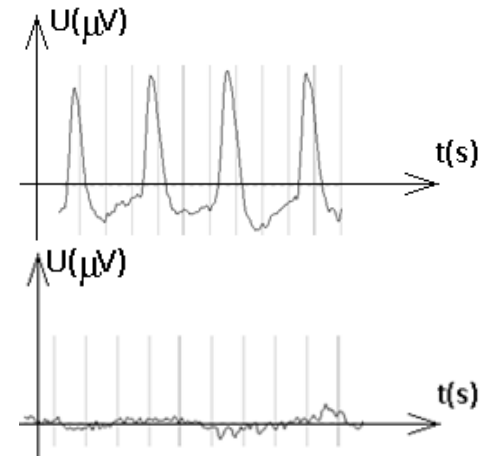
Fig 3 . Technical artefacts related to a 50 Hz network (Fourier transform – frequency domain). Top – stationary, bottom – mobile.